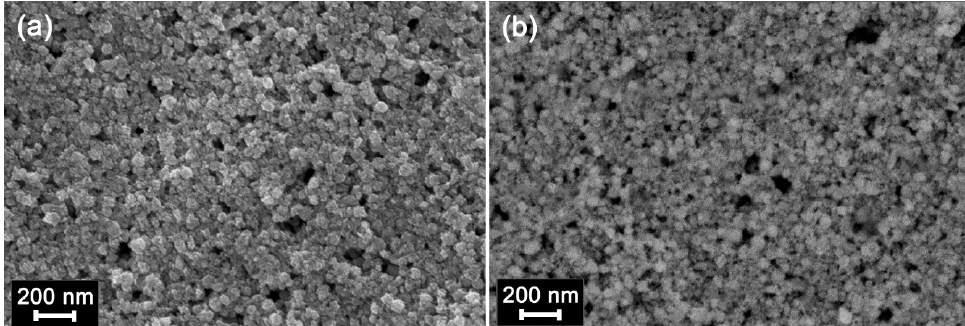
Figure 2. SEM images of In 2 O 3 ( a ) and SnO 2 ( b ) thick films deposited on functional substrates (see Materials and Methods) and sintered at 300 °C.